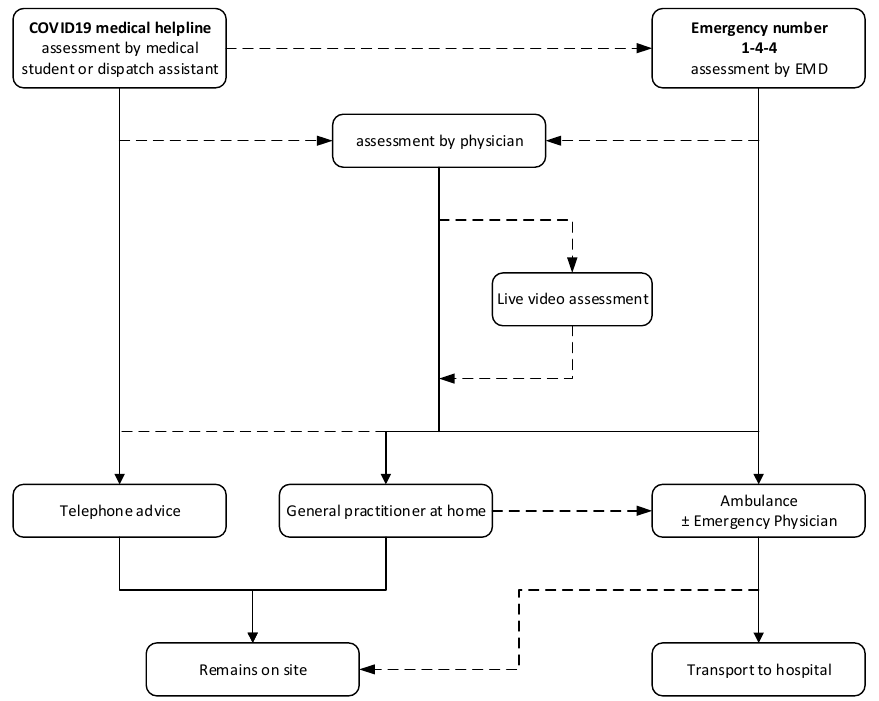
Figure 1. Geneva’s EMCC organization during the COVID-19 pandemic (solid arrows show frequent decisions or routine actions, while dashed arrows show less frequent decisions or possible but more unusual actions).